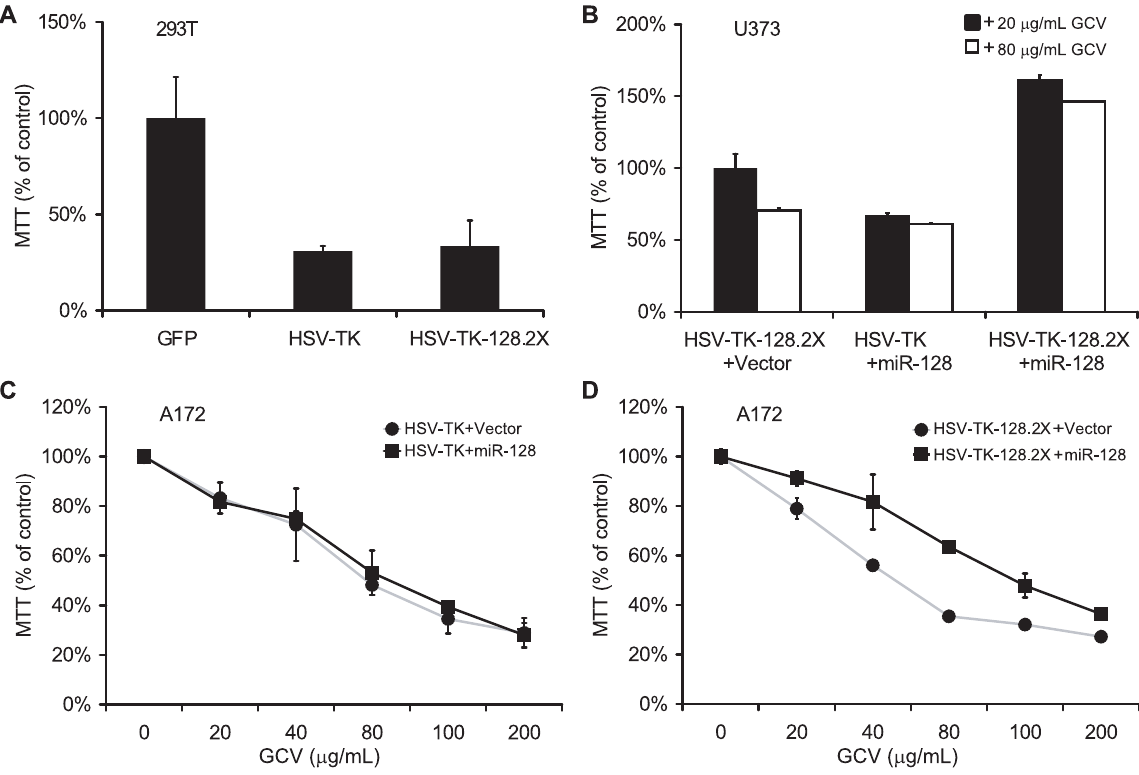
Figure 4. MiRNA regulation of HSV-TK in transduced glioblastoma cell lines. A. miR-128 binding sites have no effect on HSV-TK-mediated killing in cells lacking miR-128. 293T cells were transduced with pLCE (GFP), pL-HSV-TK, or pL-HSV-TK-128.2X and cultured for two weeks in the presence of 40 m g/ml GCV (n=2). Cell viability was measured by MTT assay. B. miR-128 rescues glioblastoma cells from killing by HSV-TK-128.2X. U373 cells were transduced with indicated vectors in 6-well plates. 24 hrs post-transduction, cells were transfected with pcDNA3 or pcDNA3-miR-128 using Lipofectamine 2000. 24 hrs later, cells were plated in 24-well plates and cultured for 2 weeks in 20 m g/ml or 80 m g/ml GCV (n=2). C and D. Dose-dependent response to GCV. A172 cells were transduced with indicated vectors, then transfected with pcDNA3 (grey lines, circles) or pcDNA3- miR-128 (black lines, squares). 24 hrs later, cells were plated in 24-well plates and cultured for 2 weeks in the presence of GCV (n=2). Cell viability was measured by MTT assay (B–D).